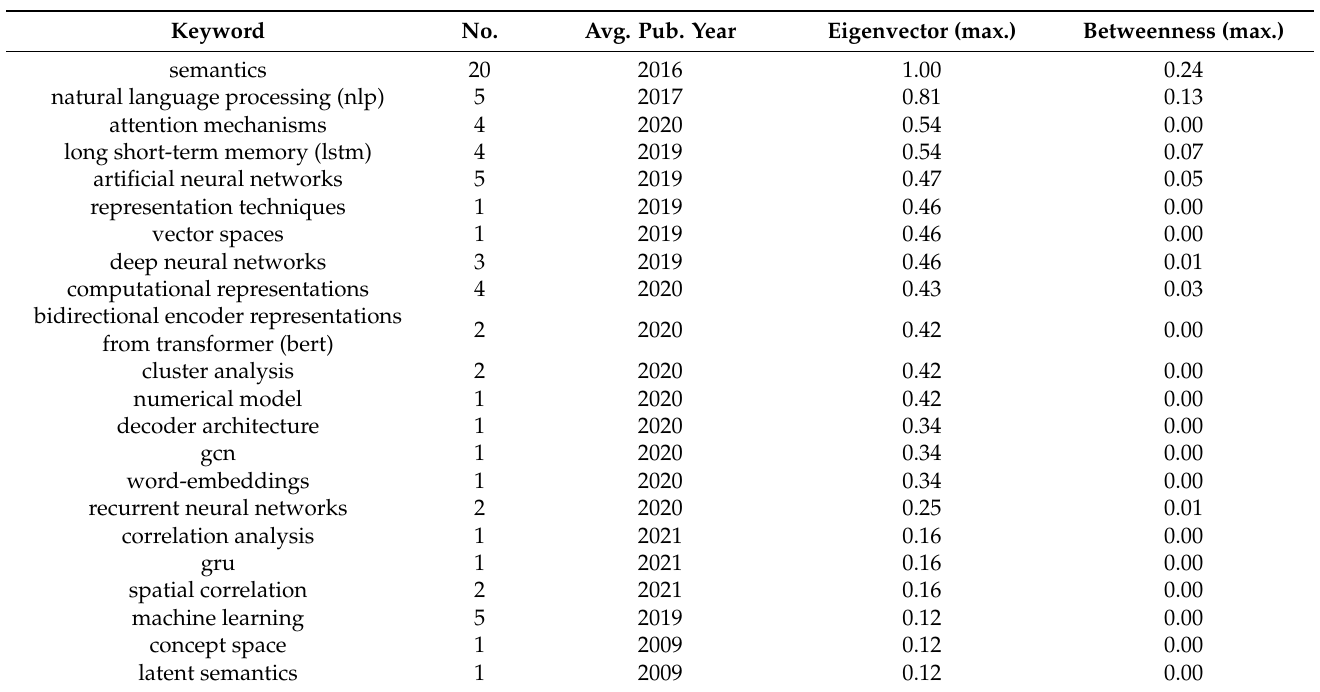
Figure 9. Network overlay of keyword occurrences related to methods/algorithms. Table 6. Main algorithms/methods-related keywords (by no. of occurrences, average publication year, eigenvector, and betweenness centrality